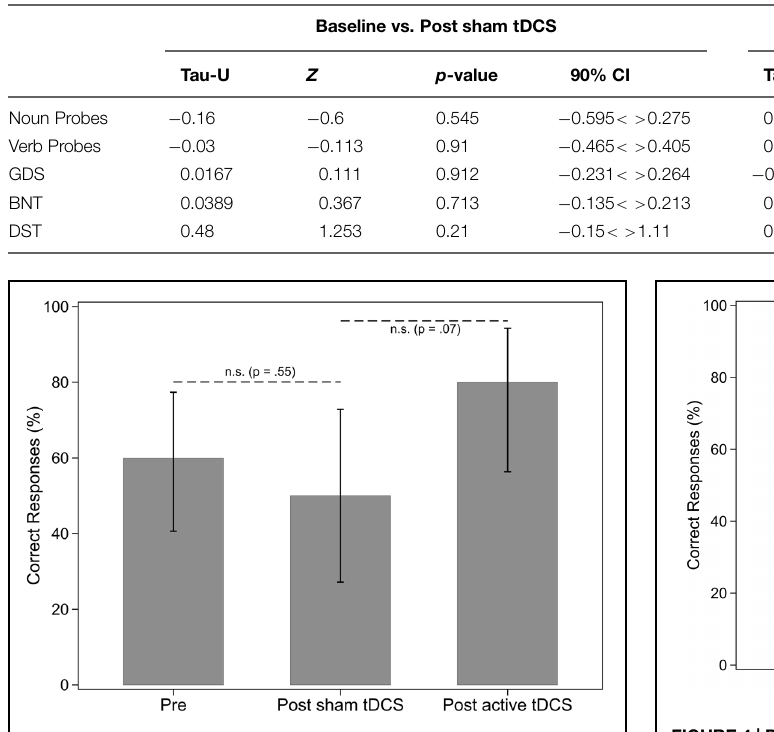
FIGURE 3 | Percentage of nouns in sentences correctly identified, by treatment phase. Error bars: 95% CI.